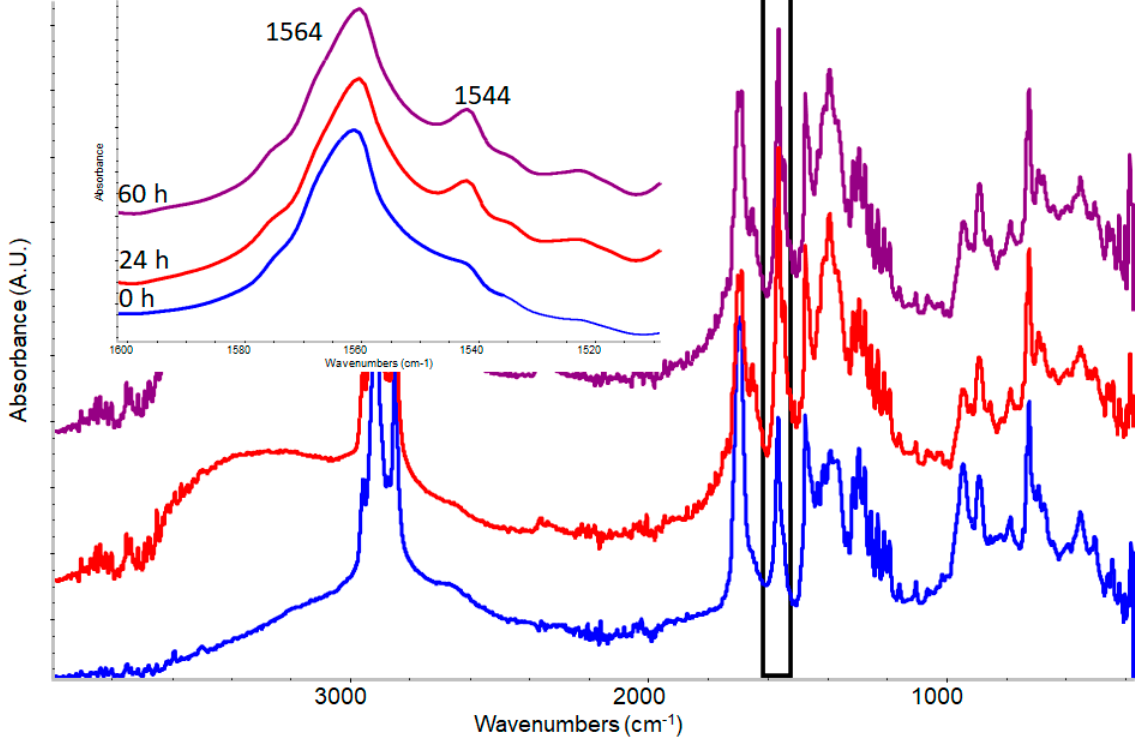
Figure 5. Kinetics of potassium carboxylates formation from a mixture 1:2:1 ( w / w ) of palmitic acid, KOH and abietic acid. In the box the spectral range from 1500 to 1600 cm − 1 is highlighted.